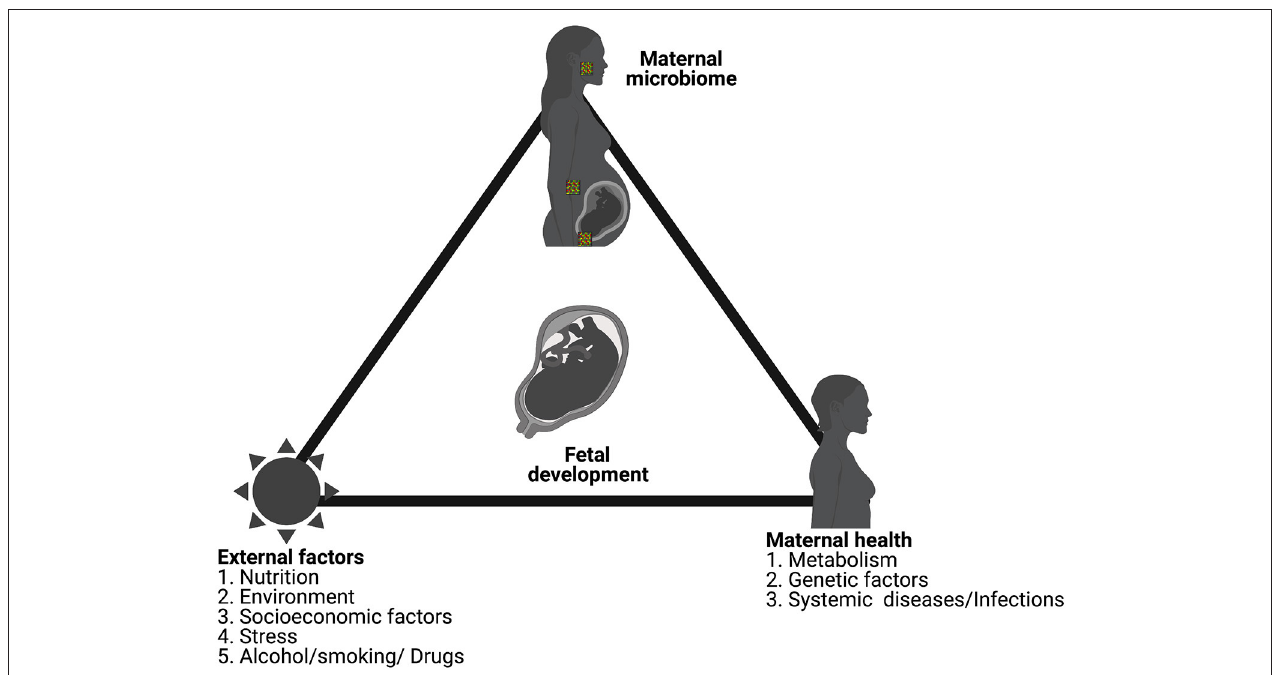
FIGURE 4 | Normal fetal development is a consequence of the overall health of the mother, surrounding environmental factors and the maternal microbiome. Figure created using the BioRender software.